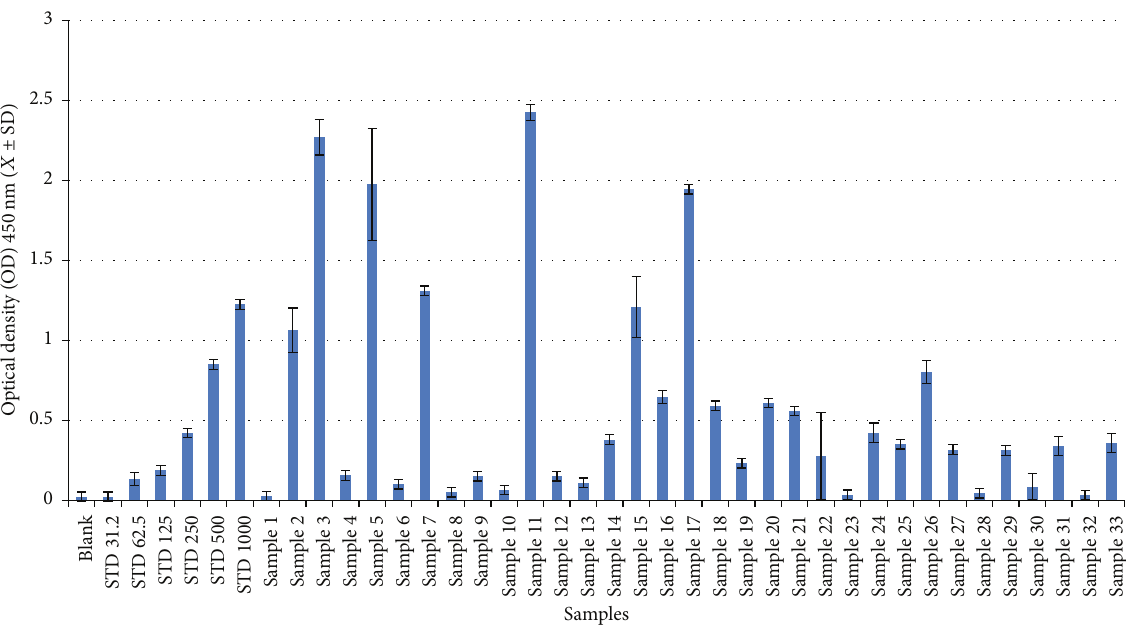
Figure 1: Concentration distribution of human total defensins in patient sera.